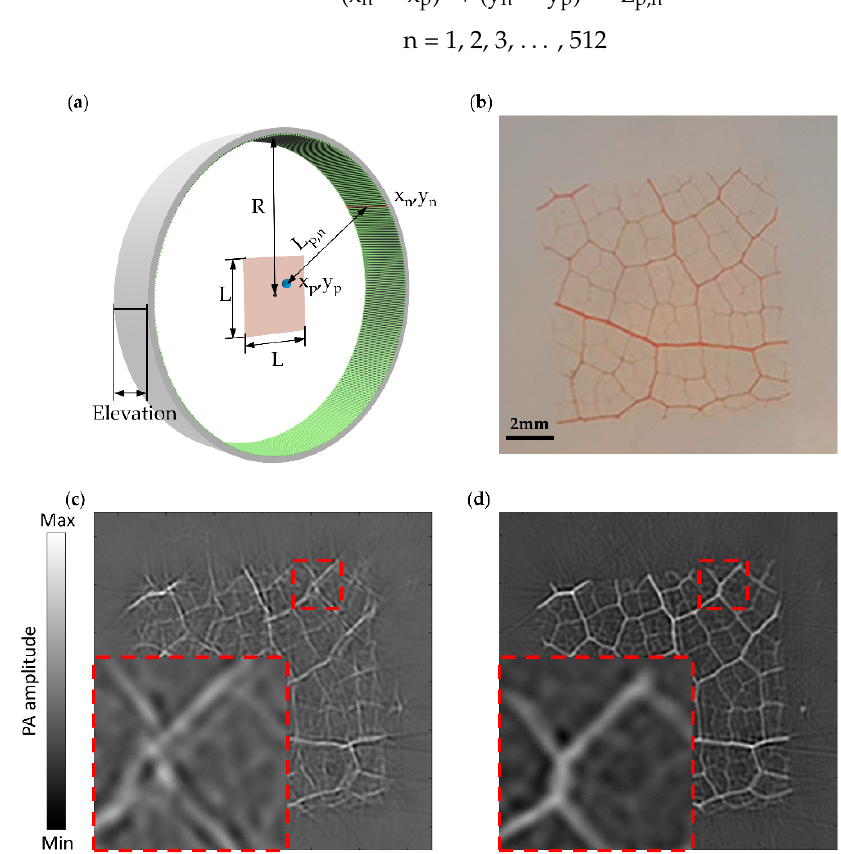
Figure 5. Theoretical analysis model and the comparison of results before and after transducer geometry correction. ( a ) The definition of both the array element coordinates and the FOV of the image reconstruction area. (x n , y n ) represents the position of the n-th array element and (x p , y p ) represents the pixel location of the point source. L is the size of the image reconstruction area. L p,n is the distance between the array element (x n , y n ) and the pixel point (x p , y p ); ( b ) The sample of leaf vein for imaging; ( c , d ) The PA image of the leaf vein before and after transducer geometry correction. The red dotted box is a close-up of the same area of the leaf